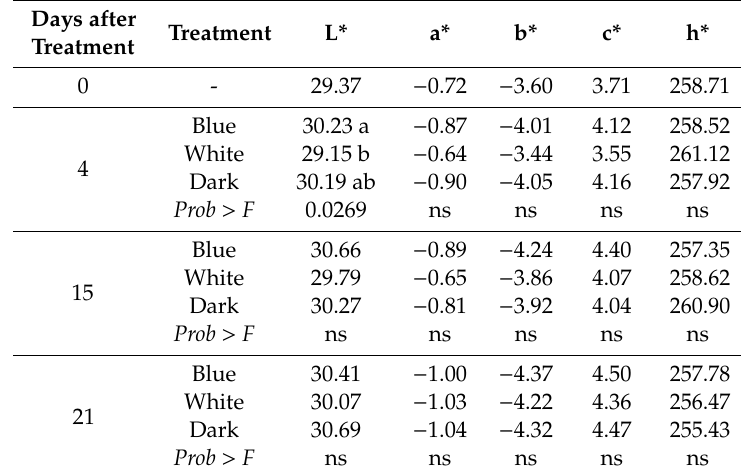
Table 3. Color values in ripe ‘Star’ southern highbush blueberries subjected to light treatments at various times during cold storage.